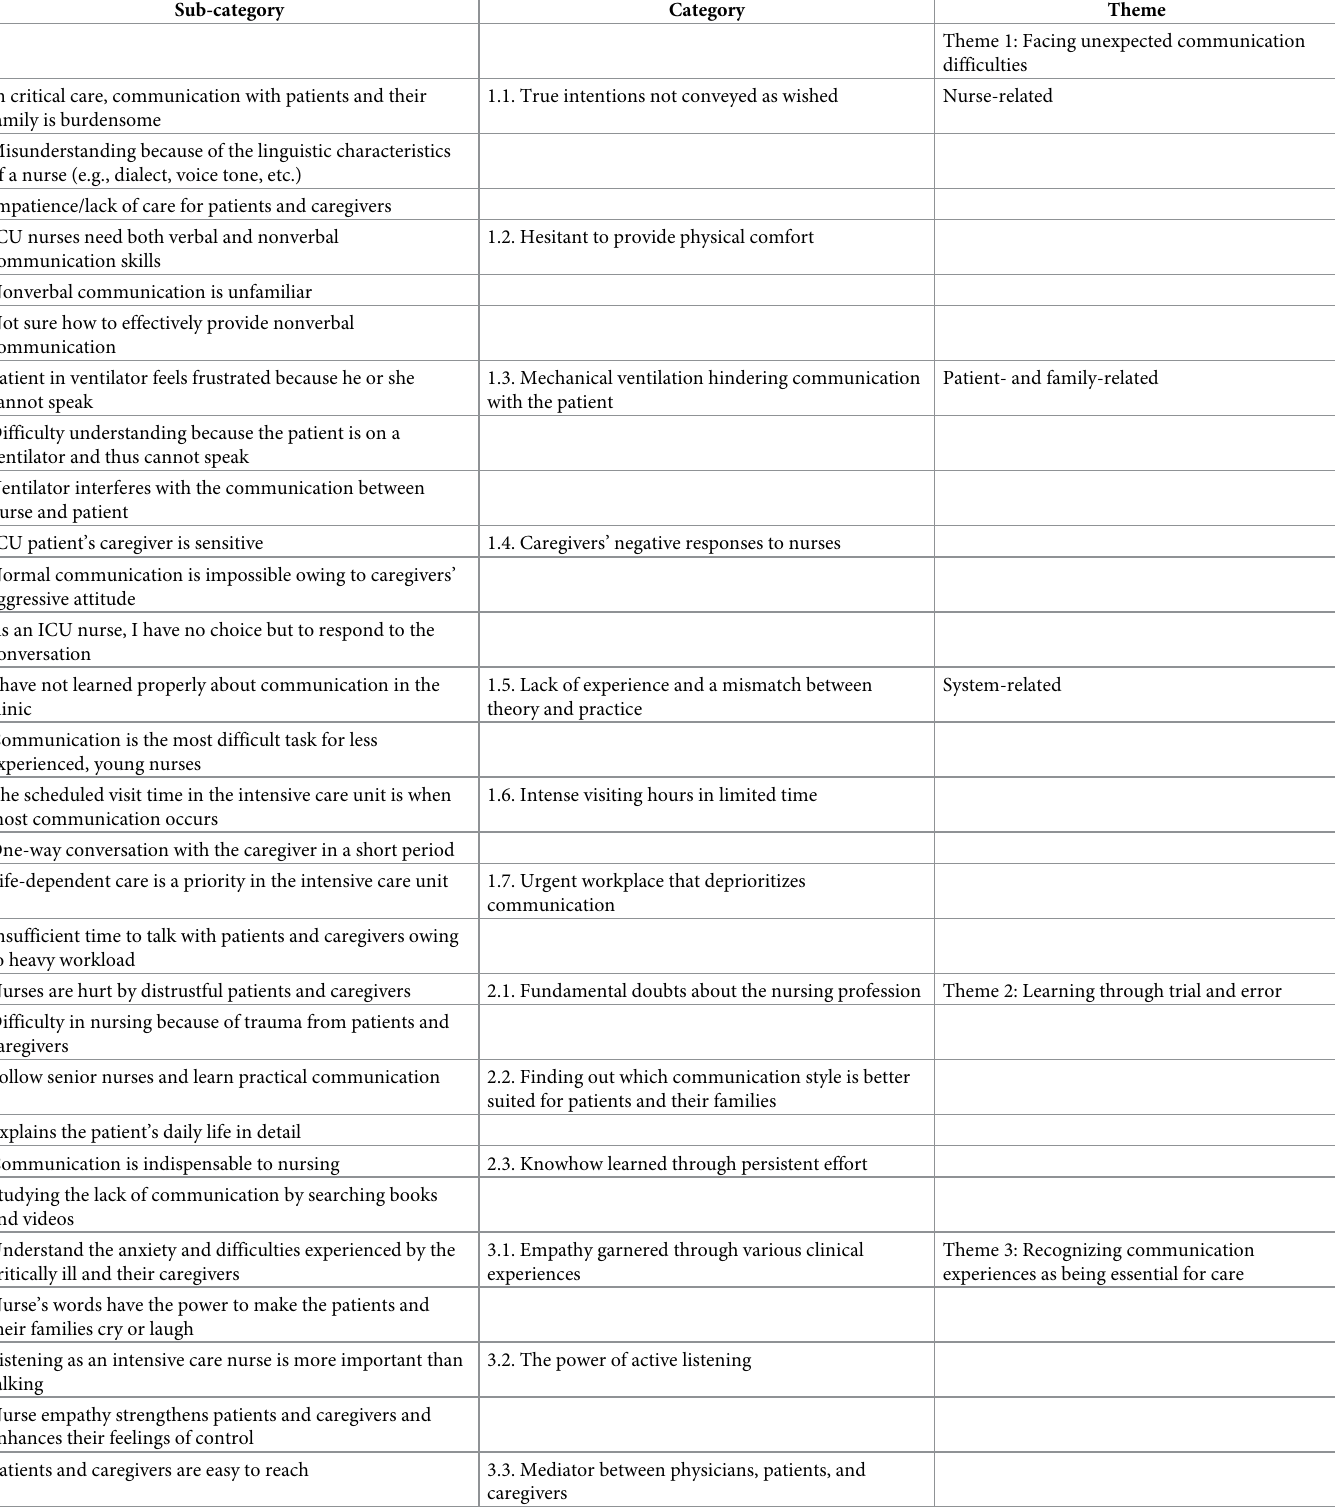
Table 3. Critical care nurses’ communication experience with patients and their